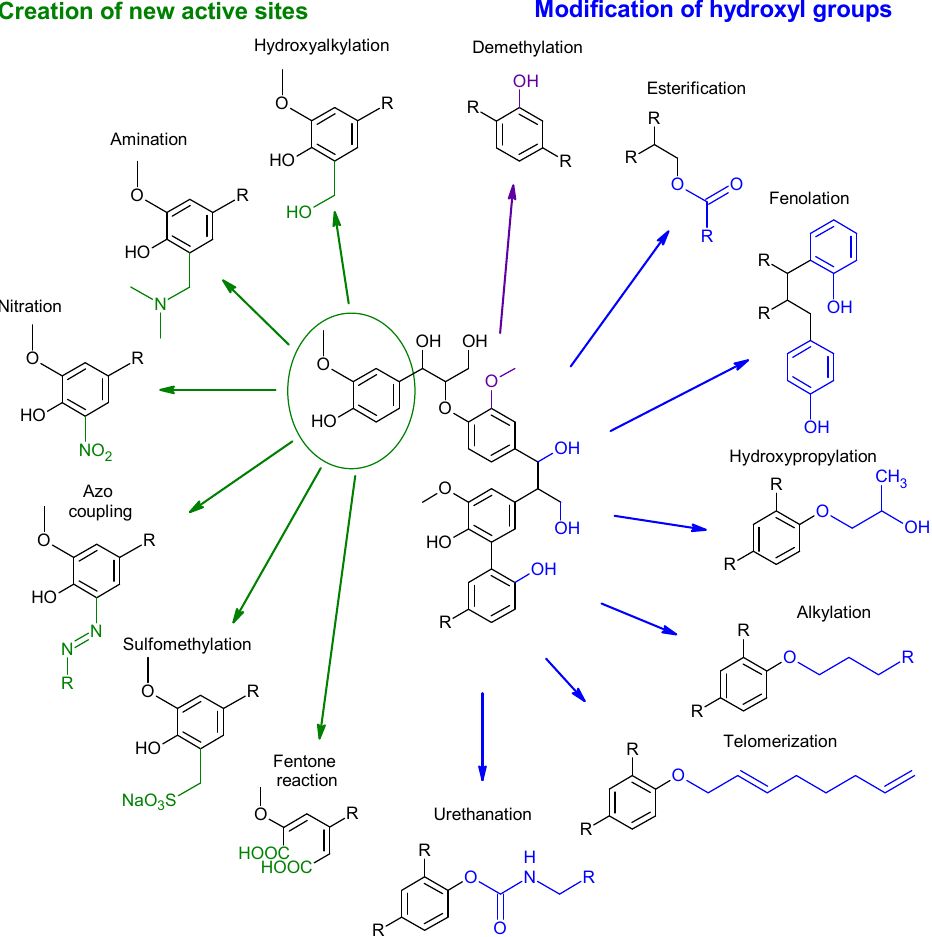
Figure 5. Simplified schematic of the most promising and studied modifications of